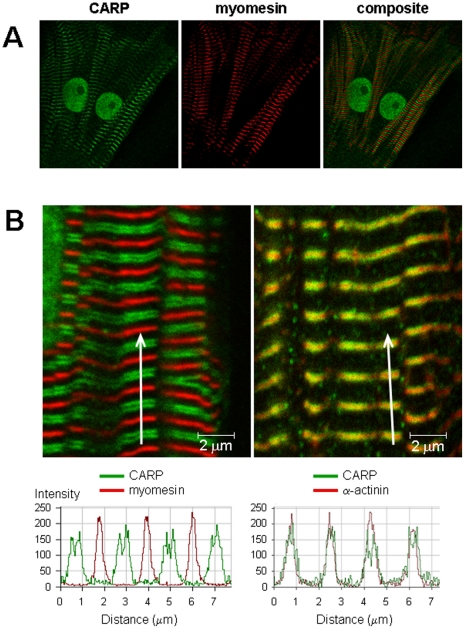
Sarcomeric and nuclear localization of CARP in ARVMs.
A: Low magnification (40×) images of ARVMs co-stained with antibodies to CARP (green) and myomesin (red). B: High magnification (100×) of ARVMs immunostained for CARP (green) and myomesin (red, left image) or α-actinin (red, right image), and shown below the image is the corresponding fluorescence intensity along the white arrow in the red and green channels.